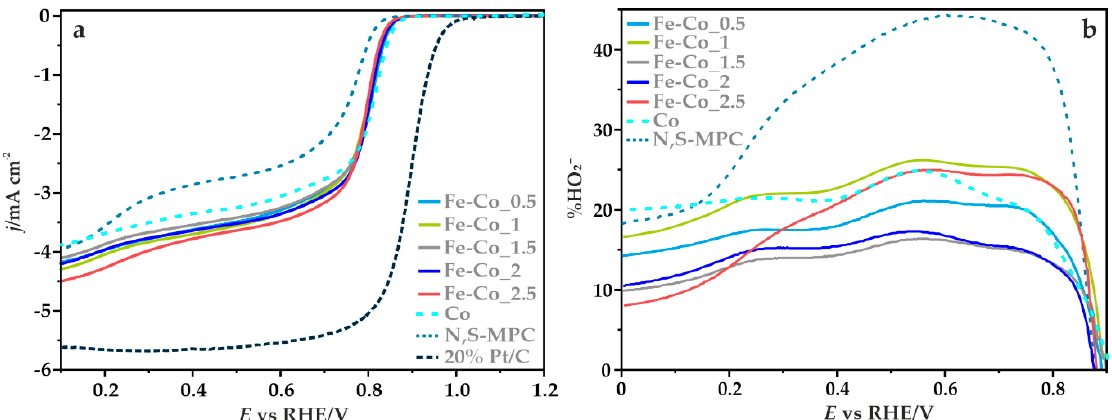
Figure 8. ( a ) The LSV profiles for the Fe-Co oxide active phase deposited on the N,S-MPC support and for the bare carbon support, compared with the spinel Co / N,S-MPC and Pt/C benchmark catalysts recorded in O 2 -saturated 0.1 M KOH solution at 1600 rpm; ( b ) Percentage of HO (cid:2870)(cid:2879) calculated from the RRDE measurements performed in 0.1 M KOH solution at 800 rpm.